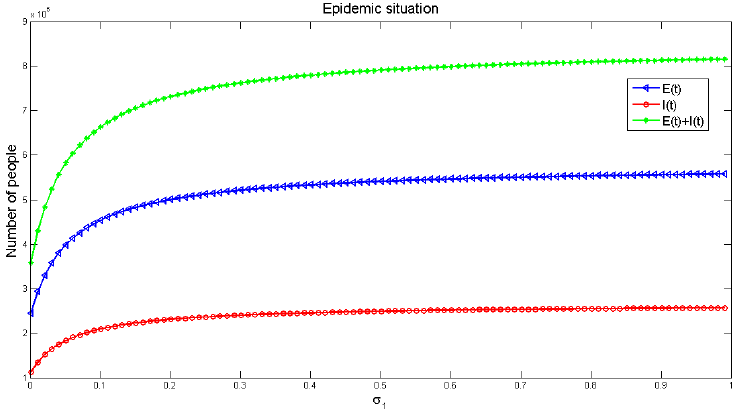
Figure 9. The effect of the ratio k on the infection number of E ( t ), I ( t ) and R ( t ) from the consciously susceptible to the unconsciously susceptible population.